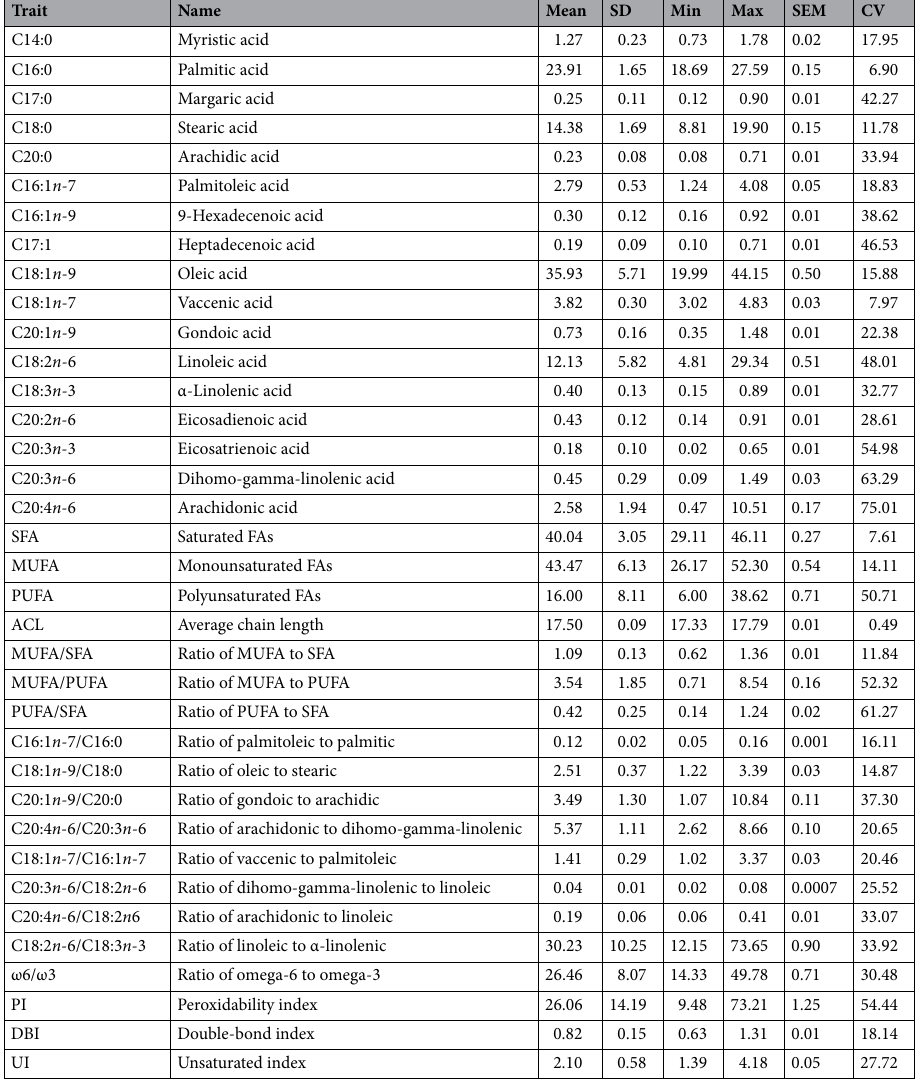
Table 1. Summary of descriptive statistics on the FA composition traits and FA metabolic indices in the LD muscle from BC1_DU pigs. Fatty acid composition is expressed as percentage of total fatty acids. SEM—standard error of the mean. CV—coefficient of variation (in percentage). The following sums of fatty acids, ratios and indexes were